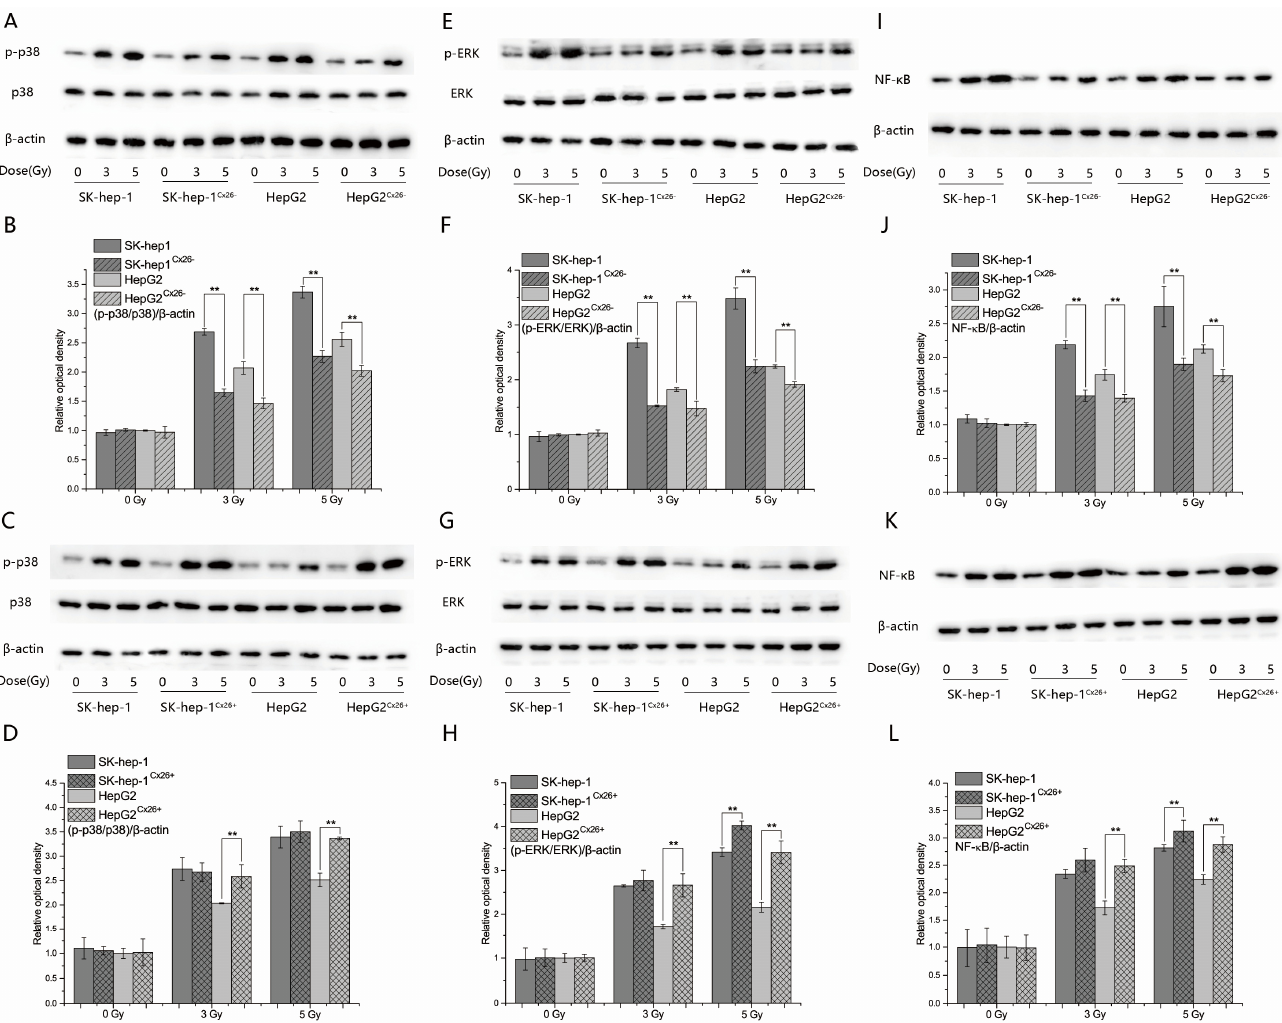
Figure 6. The expression of the MAPK and NF- κ B signaling pathways proteins in HepG2, HepG2 Cx26 − , HepG2 Cx26+ , SK-hep-1, SK-hep-1 Cx26 − and SK-hep-1 Cx26+ cells after X-ray irradiation. ( A ) The expression of p-p38 and p38 in HepG2 Cx26 − and SK-hep-1 Cx26 − cells after X-ray irradiation. ( B ) Quantification of p-p38/p38 expression in HepG2 Cx26 − and SK-hep-1 Cx26 − cells after X-ray irradiation. ( C ) The expression of p-p38 and p38 in HepG2 Cx26+ and SK-hep-1 Cx26+ cells after X-ray irradiation. ( D ) Quantification of p-p38/p38 expression in HepG2 Cx26+ and SK-hep-1 Cx26+ cells after X-ray irradiation. ( E ) The expression of ERK/ERK in HepG2 Cx26 − and SK-hep-1 Cx26- cells after X-ray irradiation. ( F ) Quantification of ERK/ERK expression in HepG2 Cx26 − and SK-hep-1 Cx26 − cells after X-ray irradiation. ( G ) The expression of ERK/ERK in HepG2 Cx26+ and SK-hep-1 Cx26+ cells after X-ray irradiation. ( H ) Quantification of ERK/ERK expression in HepG2 Cx26+ and SK-hep-1 Cx26+ cells after X-ray irradiation. ( I ) The expression of NF- κ B in HepG2 Cx26 − and SK-hep-1 Cx26 − cells after X-ray irradiation. ( J ) Quantification of NF- κ B expression in HepG2 Cx26 − and SK-hep-1 Cx26 − cells after X-ray irradiation. ( K ) The expression of NF- κ B in HepG2 Cx26+ and SK-hep-1 Cx26+ cells after X-ray irradiation. ( L ) Quantification of NF- κ B expression in HepG2 Cx26+ and SK-hep-1 Cx26+ cells after X-ray irradiation. ** p < 0.01 compared between the two cells.